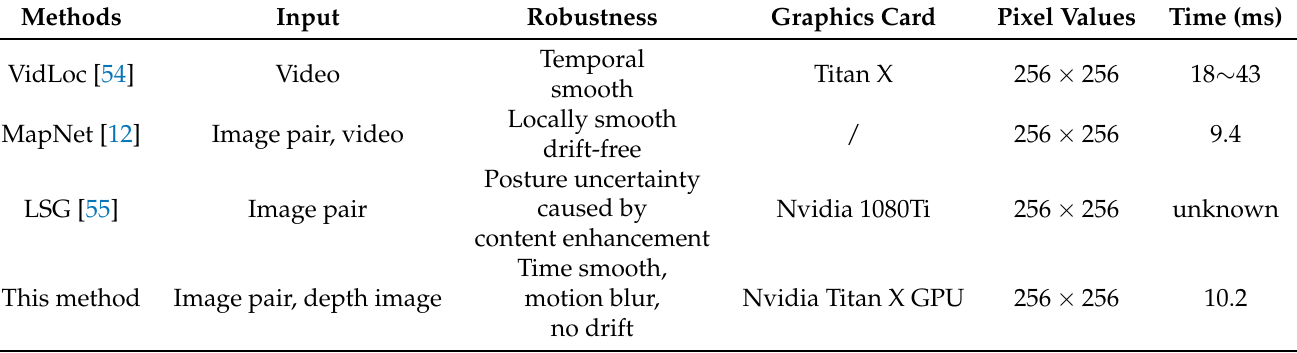
Table 5. Comparison of experimental qualitative results between the method of fusing local and global features and other